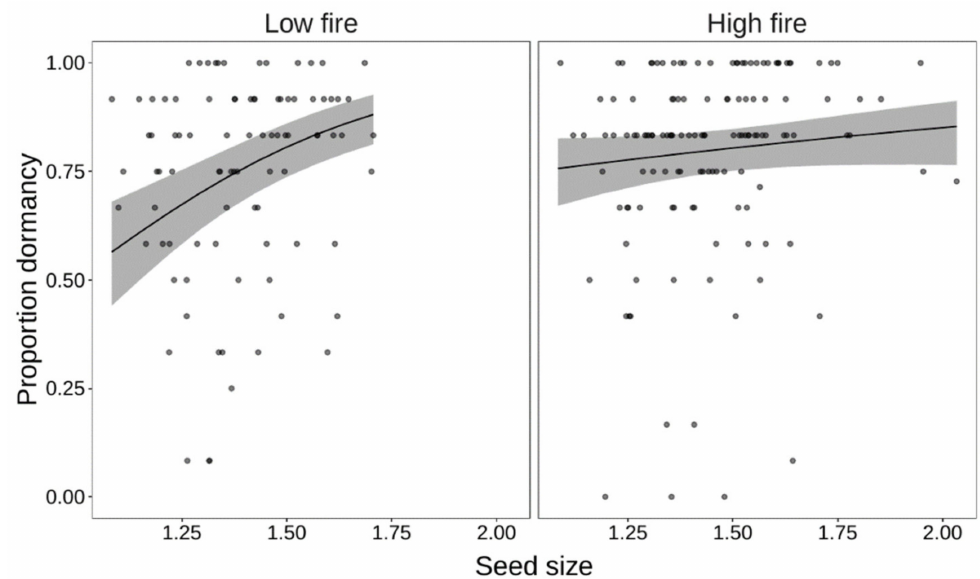
Figure 3. Relationship between dormancy and seed size (mm 2 ) in Cistus salviifolius , in ‘low-fire’ coastal shrubland and ‘high-fire’ Mediterranean heathland habitats. Dots represent plant individuals. Regression lines and 95% confidence intervals of predicted models are shown (seed size ranged from